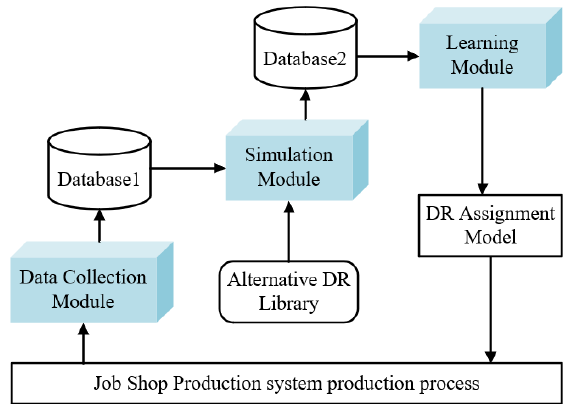
Figure 4. Assigned DR model construction process.